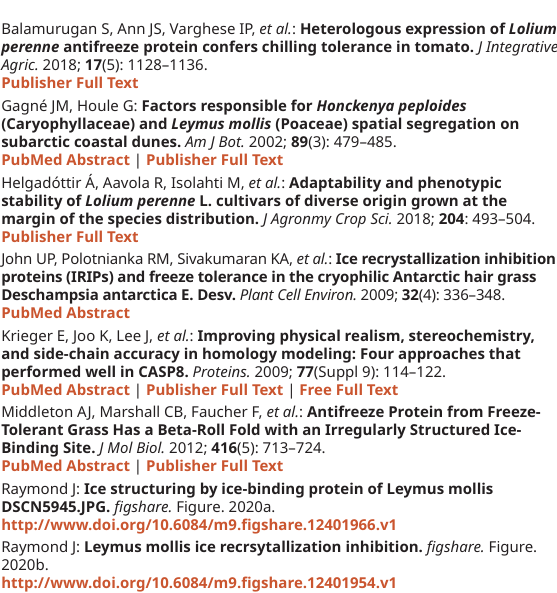
Figshare: Ice structuring by ice-binding protein of Leymus mollis